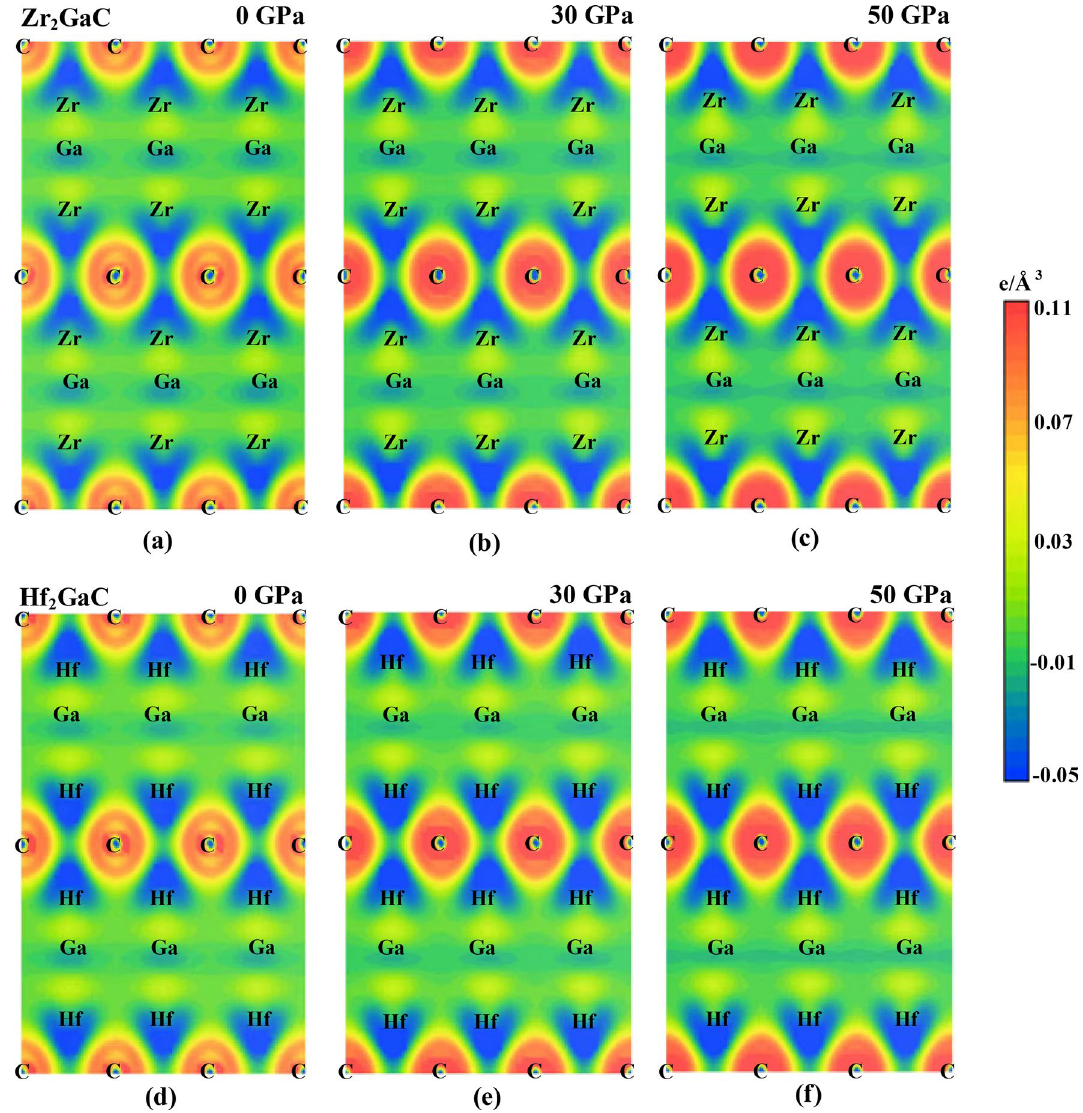
Figure 8. Electronic charge density mapping along the (100) plane for Zr 2 GaC at a 0 pressure, b 30 GPa, and c 50 GPa, and for Hf 2 GaC at d 0 pressure, e 30 GPa, and f 50 MAX phases have well-defined bonding and antibonding regions with crossover points near the Fermi level, which is an indication of covalent bonding nature. There is no occupation of antibonding orbitals in the M–C bonds of Zr 2 GaC and Hf 2 GaC MAX phases. Moreover, the occupied region below the Fermi level is dominated by strong M–C interaction, while at the Fermi level, the M–Ga bonding character was dominant. There is almost zero bonding interaction for Ga–C atoms due to the absence of orbital overlapping. The COHP curves are similar to the most studied Al-containing MAX phases 77 . Furthermore, the calculated values for metallicity and Fermi energy in the pressure range 0–50 GPa are tabulated in Table 1. It is observed that the metallicity of both Zr 2 GaC and Hf 2 GaC phases increases with increasing pressure. According to Eq. (6), the conductivity mainly depends upon n 2 GaC > Zr 2 GaC. To insight the chemical bonding of M 2 GaC MAX phases under pressure, the charge density distributions mapping along the (100) plane at 0 GPa, 30 GPa, and 50 GPa are plotted in Fig. 8. The bonding character of MAX phases is essential to understand the chemical bonding of their 2D derivatives (MXenes) 79,80 . The preferential accumulation of charges (positive regions at the scale bar) between two atoms indicates the covalent bonds, while balancing the positive or negative (depleted regions) charges at atomic position exhibits the ionic bonding 81 . At 0 GPa, the strong charge accumulation regions were observed at C and M = Zr, Hf atoms, indicating the forma- tion of a strong covalent bond between C–Zr and C–Hf atoms. The charge accumulation at these atomic posi- tions increases with an increase in pressure due to the decrease in atomic distance and an increase in internal